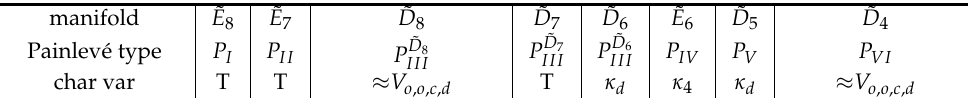
Table 1. The manifold type according to the Dynkin diagram (row 1 ), the corresponding Painlevé equation (row 2) and the main factor in the Groebner base for the corresponding SL ( 2, C ) variety. The symbol T means that the variety is trivial (up to quadratic factors). manifold ˜ E